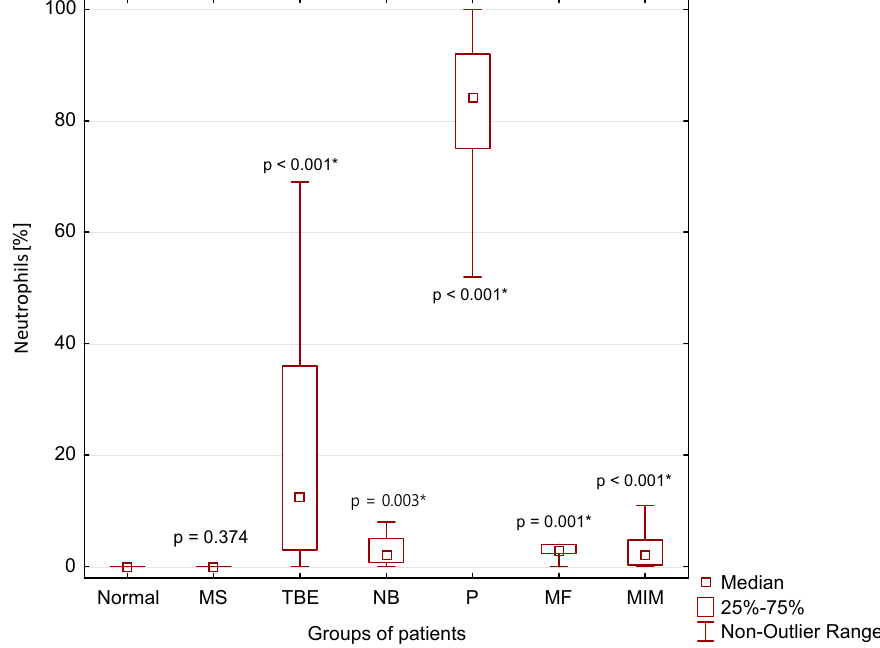
Figure 4. Percentage of lymphocytes in CSF in our patient groups (*: statistically significant). A significantly higher percentage of neutrophils in CSF compared to normal CSF findings was found in patients with TBE ( p < 0.001), NB ( p = 0.003), P ( p < 0.001) and MIM ( p > 0.001). The absolute highest neutrophil count is typical for patients with purulent inflammation in the CNS (P) (Figure 5).